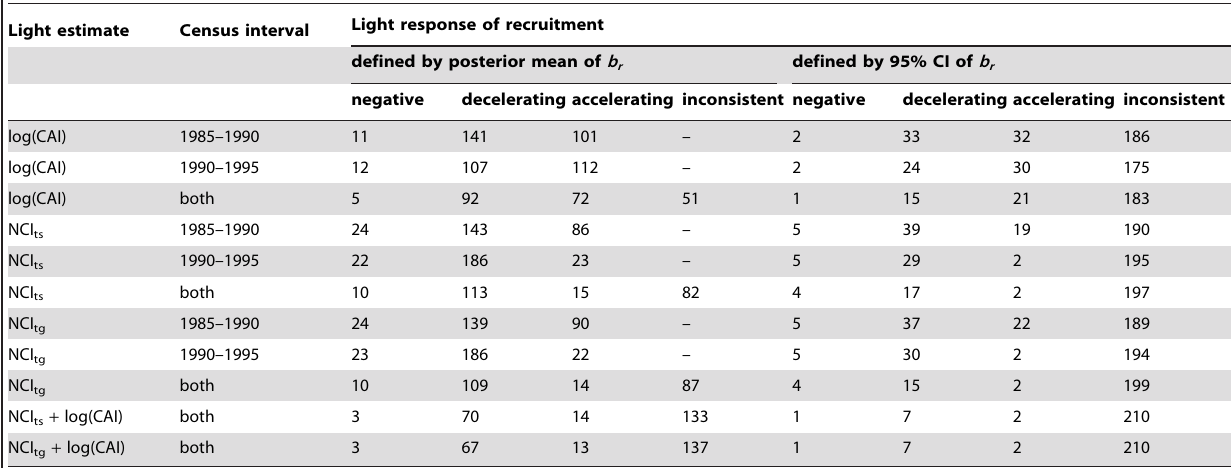
Table 1. Classification of tree species on the basis of their recruitment responses to light availability: negative ( b r , 0), decelerating (0 , b r , 1) and accelerating ( b r .